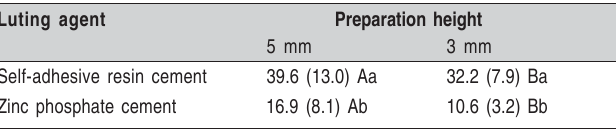
Table 1. Means (standard deviations) tensile strength values (kgf) for the different experimental